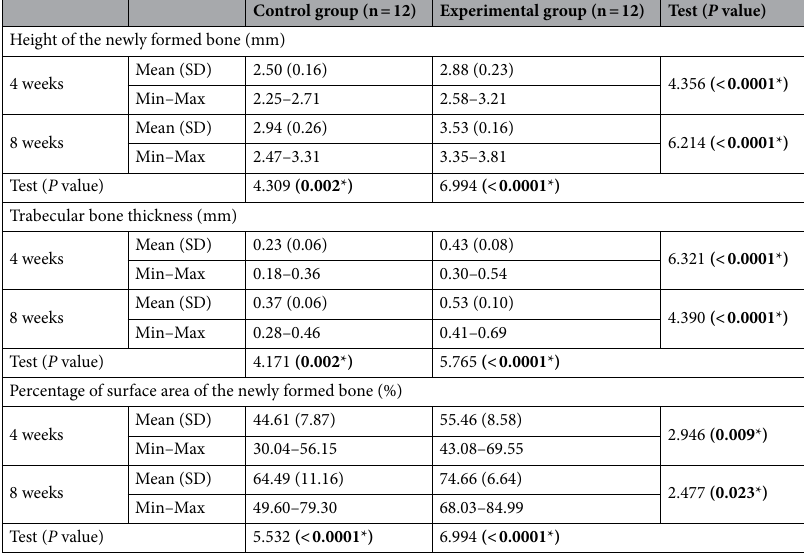
Table 1. Comparison between the experimental and control groups regarding the height of the newly formed bone, trabecular bone thickness, and the Percentage of the surface area of the newly formed bone after 4 and 8 weeks. *Statistically significant difference at p value < 0.05. Significant values are in